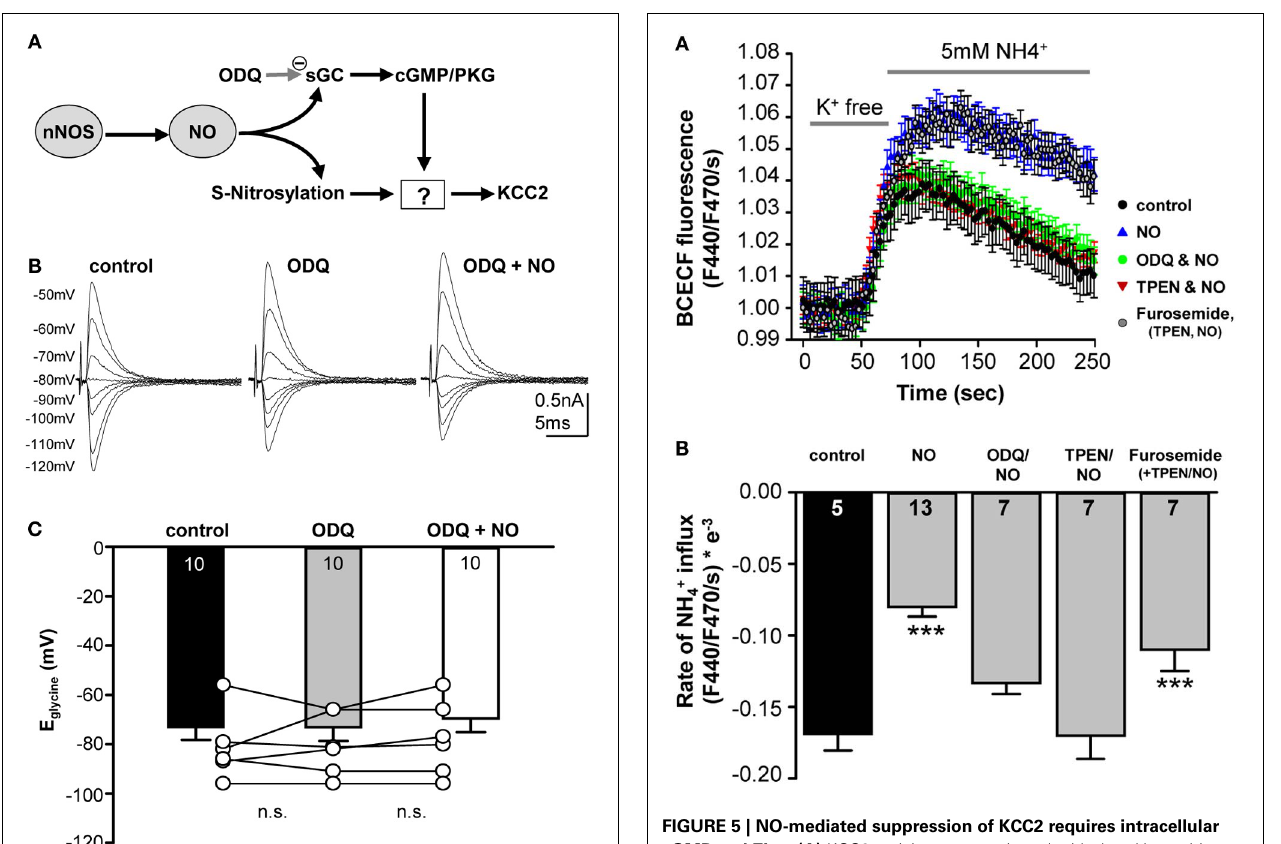
FIGURE 5 | NO-mediated suppression of KCC2 requires intracellular cGMP and Zinc. (A) KCC2 activity was monitored with the pH-sensitive dye BCECF in SHSY-5Y cells that express endogenous KCC2. Cells were incubated for 5min with K + free extracellular solution, and the rate of intracellular pH change following application of NH 4 Cl (5mM) was monitored (see Materials and Methods). (A,B) Plots of NH + 4 - mediated acidification rates (mean ± s.e.m.) in control, treated with NO, NO + ODQ, NO + TPEN, or ODQ + TPEN + furosemide. Significance was assessed using a One-Way ANOVA. Ns are given in the bars. ∗∗∗ p ≤ 0 .